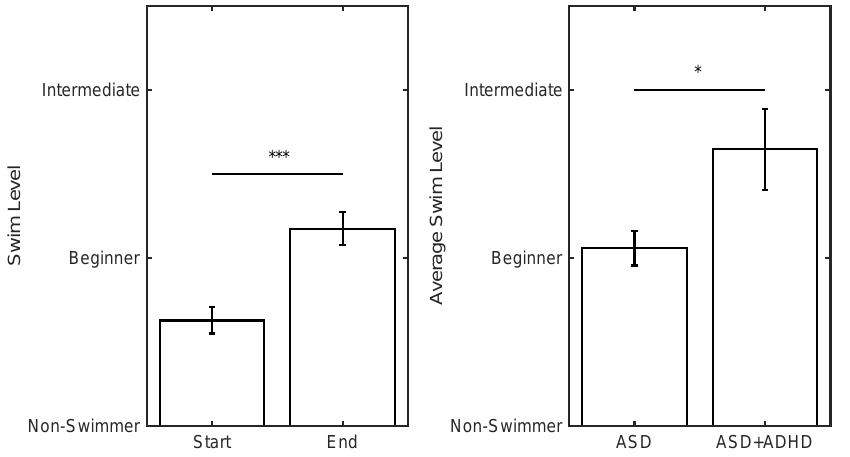
Figure 2. ( Left ) Swim level by time (start/end). ( Right ) Average swim level by ADHD status (ASD/ASD + ADHD). The bars represent the group means, and the error bars represent the standard error of the mean. * = p < 0.05, *** = p < 0.001.